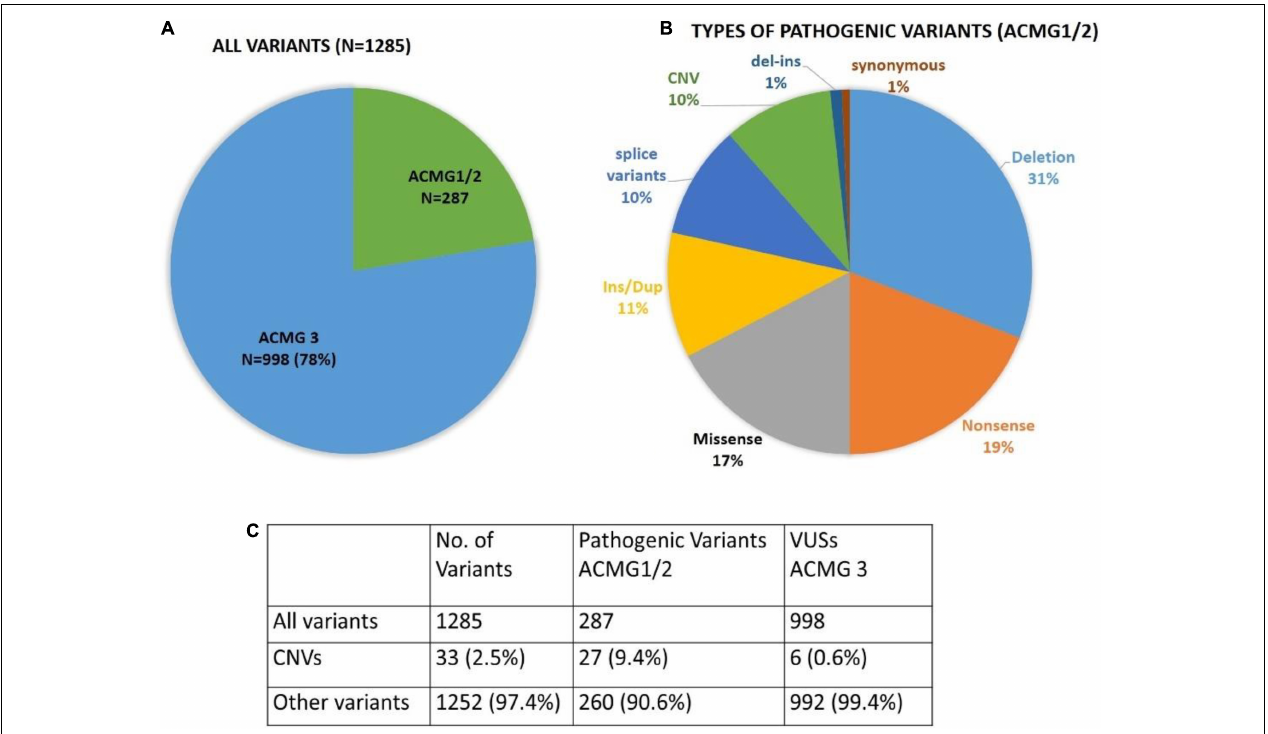
FIGURE 2 | Frequency of pathogenic variants and variants of unknown significance identified in the study. This figure gives information about frequency of different types of variants (A) Pie chart showing number of pathogenic variants (ACMG 1 and 2) and ACMG 3 (variants of unknown significance), (B) Pie chart showing frequency of different types of pathogenic variants (ACMG 1 and 2), (C) Table showing frequency of copy number variants (CNVs) and sequence variants.